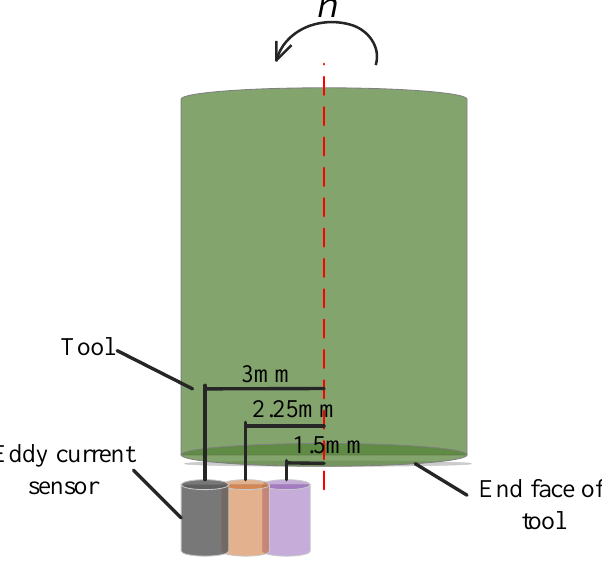
Figure 9. Different position of eddy current sensor. Figure 8a presents the vibration curve of the tool with rotation and without load when the tool grinding speed was 5.03 m/s (12,000 r/min), the output power of the ultrasonic power supply was 45% and the maximum amplitude of the electroplated grinding tool was 27.2 µ m. By filtering the vibration curve in Figure 8a, the curve can be decomposed into two curves with different frequencies, as shown in Figure 8b,c. In Figure 8b, the amplitude of axial run-out is 15.62 µ m and the frequency is 200 Hz. In Figure 8c,